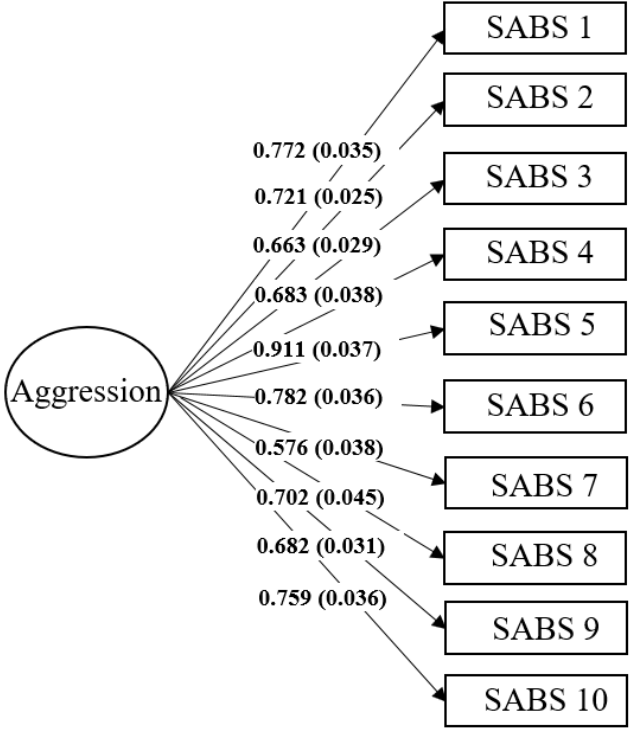
Figure 3. The single factorial structure of the Portuguese Version of SABS for CFA Total sample. Values represent standardized regression weights and standard error within brackets .